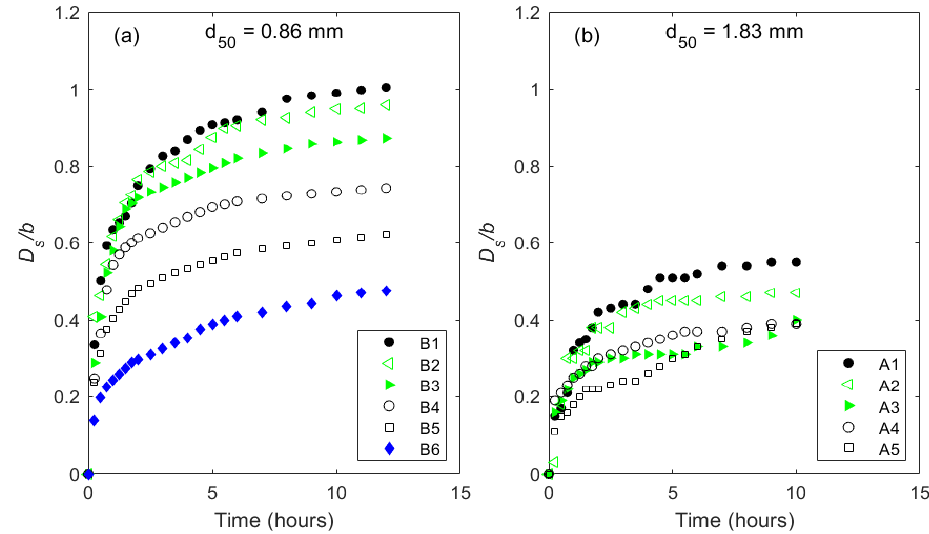
Figure 4. Time evolution of maximum scour for ( a ) the fine sediment with d 50 = 0.86 mm and ( b ) coarse sediment with d 50 =1.83 mm, where A1 and B1 are the unprotected pier and A2 to A5, and B1 to B6 are the cable protected piers.